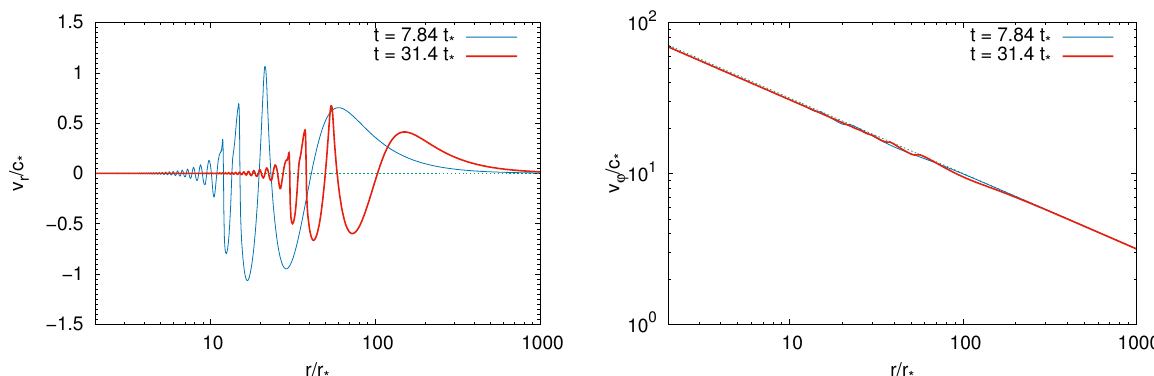
Figure 2. Radial distribution of the radial v r v r v r (left) and azimuthal v ϕ v ϕ v ϕ (right) velocities at two time moments t = 7 . 84 t ∗ t = 7 . 84 t ∗ t = 7 . 84 t ∗ and t = 31 . 4 t ∗ t = 31 . 4 t ∗ t = 31 . 4 t ∗ . Initial distributions are shown as a dotted line.